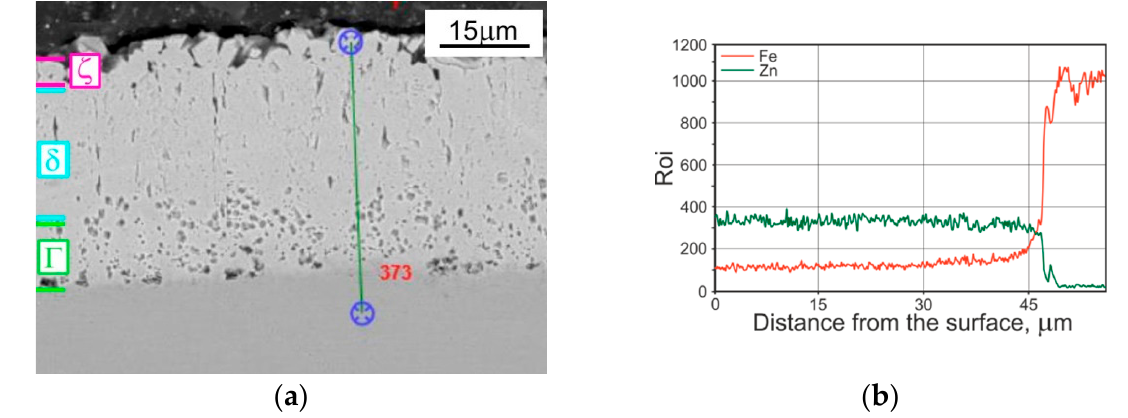
were measured in the outer coating layer for the surface grinded using sandpaper with gradation 30 and turned (385 and 383 HV 0.02). The lowest hardness values over the entire